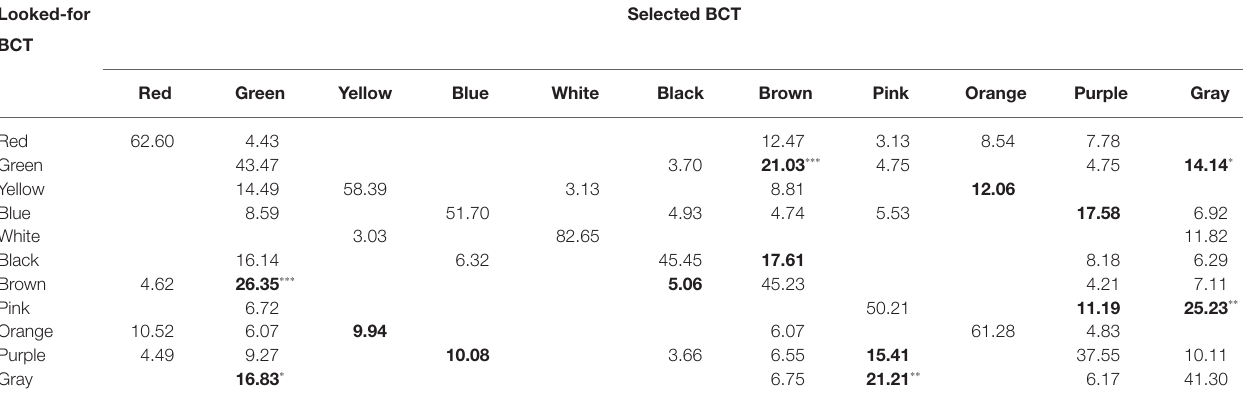
The first column indicates the looked-for BCT. The diagonal shows the percentage of specific pointing (stimuli identified as only belonging to one BCT, indicated in the first column). Other values indicate the percentage of non-specific pointing (stimuli identified as belonging to multiple BCTs). Only percentages over 3% are shown. The BCT pairs with a mean link (shared use) higher than 10% (average between both directions of the pair, e.g., Green-Brown 21.03 and Brown-Green 26.35, mean shared use is 23.69%) are in bold. The number of asterisks indicates the strength of the link for the three least discriminable BCT pairs (more asterisks, less discriminability).